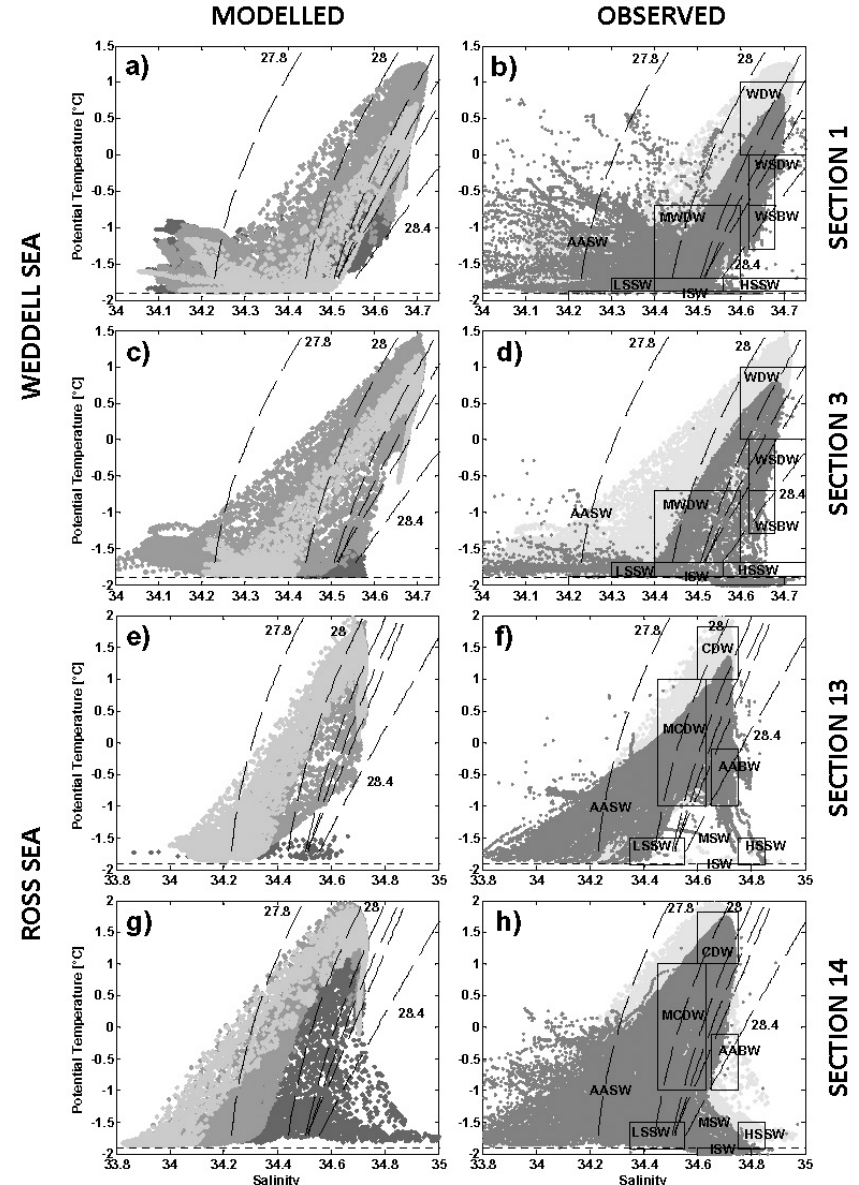
Fig. 2. (a–d) Weddell and (e–h) Ross Seas OCCAM monthly average (left column) and (right column) observed potential temperature/salinity ( θ / S ) diagrams. Colours in the left column indicate continental shelf (dark grey), continental slope (grey), and deep ocean (light grey). Colours in the right column indicate OCCAM simulation (light grey) and observations (dark grey). Dashed lines are neutral densities of 27.8, 28, 28.1, 28.2, 28.27, 28.40kgm − 3 respectively. The dotted line is the freezing point temperature. See the text for water mass definitions. Antarctic Surface Water = AASW, High Salinity Shelf Water = HSSW, Ice Shelf Water = ISW, Low Salinity Shelf Water = LSSW, Circumpolar Deep Water = CDW, Warm Deep Water = WDW, Modified CDW = MCDW, Modified WDW = MWDW, Modified Shelf Water = MSW, Antarctic Bottom Water = AABW, Weddell Sea Deep Water = WSDW, and Weddell Sea Bottom Water =